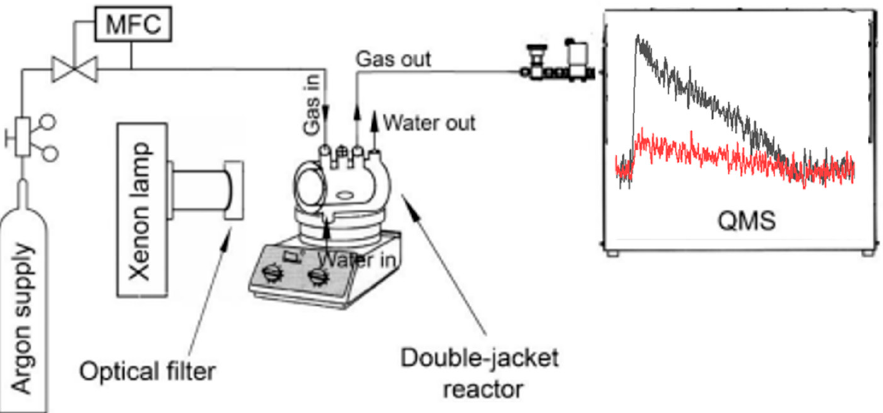
Figure 7. Experimental setup used for the continuous detection of the photocatalytic gas evolution. Adapted from [15], copyright 2020, American Chemical Society.